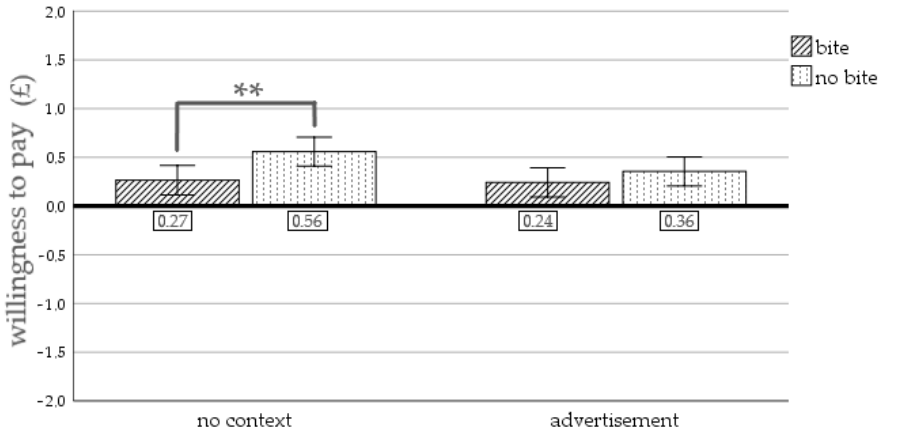
Figure 6. Results of Study 2. The interaction of picture type and context on willingness to pay. Note: ** significant at p < 0.01; error bars represent 95% confidence interval.